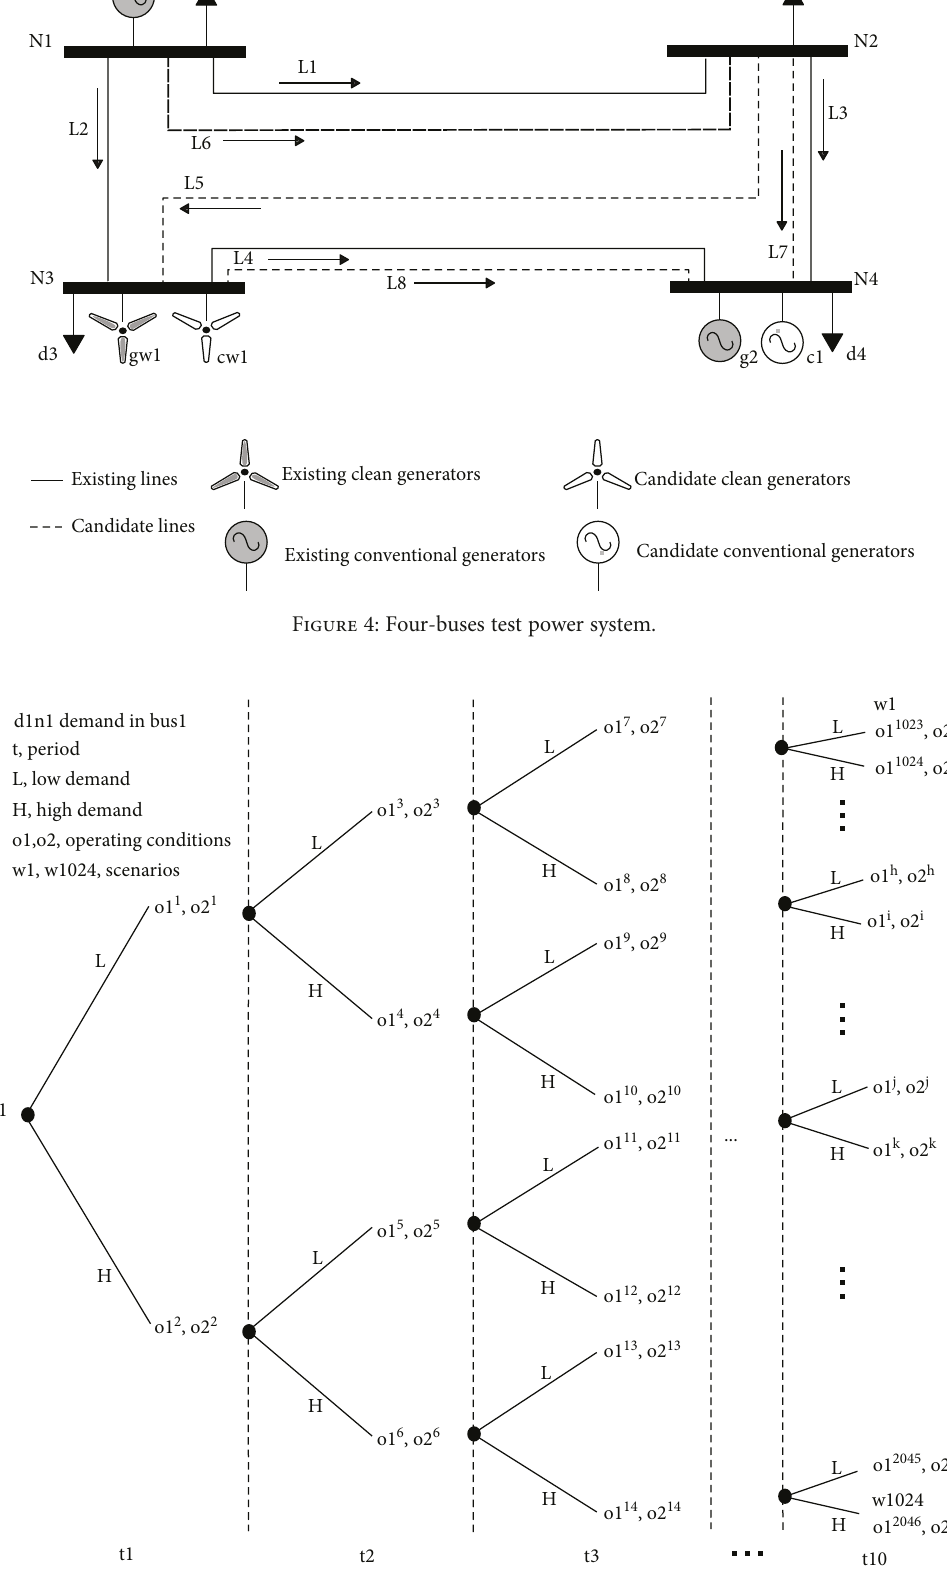
Figure 5: Scenario tree for the stochastic load demand in bus 1.